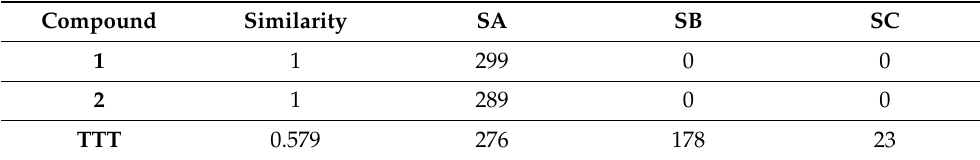
Table 2. Fingerprint similarity between compounds 1 , 2 and TTT . Compound